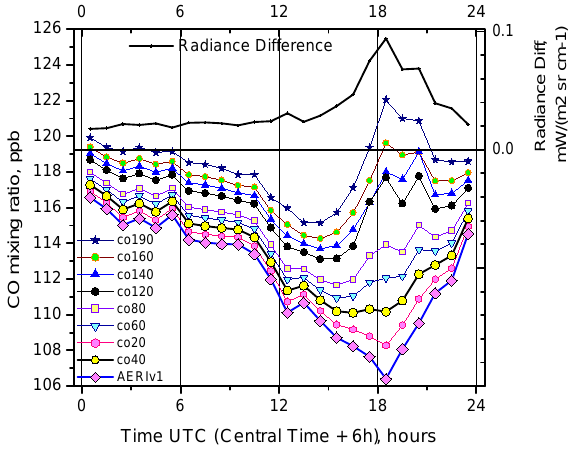
Fig. 7. Mean diurnal cycles. Top curve and right scale: a difference between measured and calculated radiance (RD) in the windows- Bottom curves and left scale: mean diurnal cycles of CO mixing ratio retrieved from the AERI spectra for 2006 and corrected for the scattered light using for different slopes, S , of the correlation be- tween CO and RD. The AERI v2 curve corresponds to the slope of − 40 where the anticorrelation of CO and RD